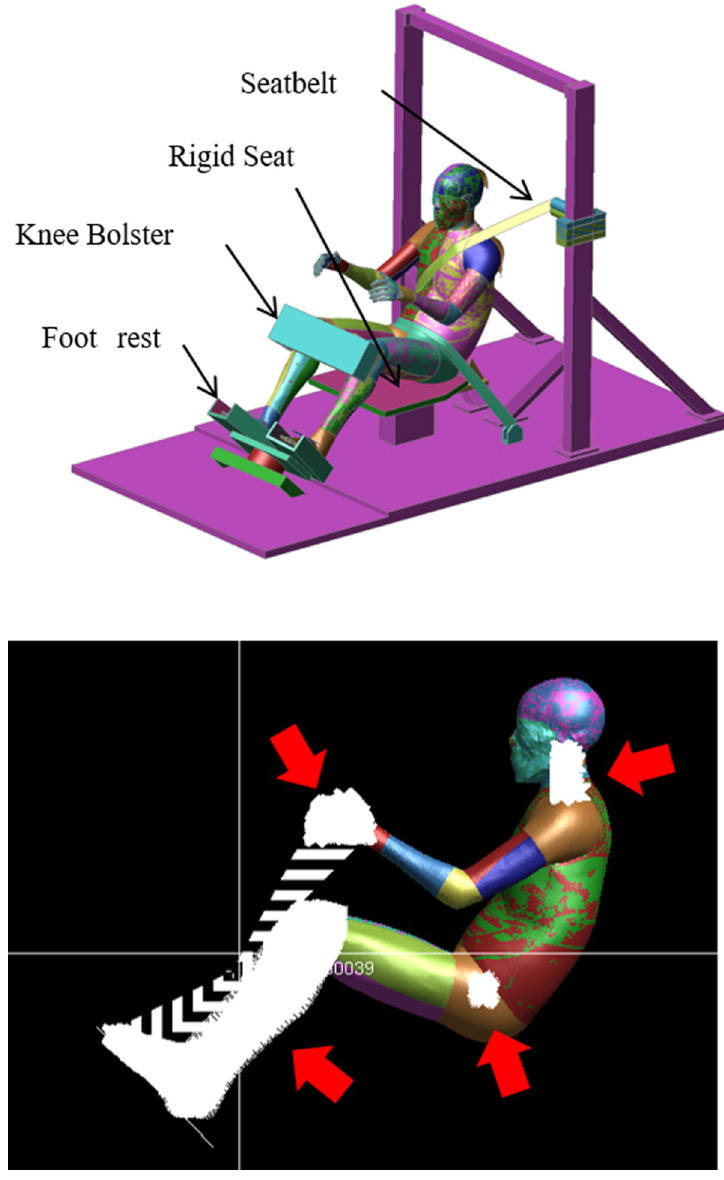
Fig 4. Initial posture of THUMS (above). Below the wrist, below the knee, and the cervical spine of THUMS were restrained (arrows). In addition, the hip joint was not restrained to flexion and extension; however, abduction, adduction, and rotation were restrained (see